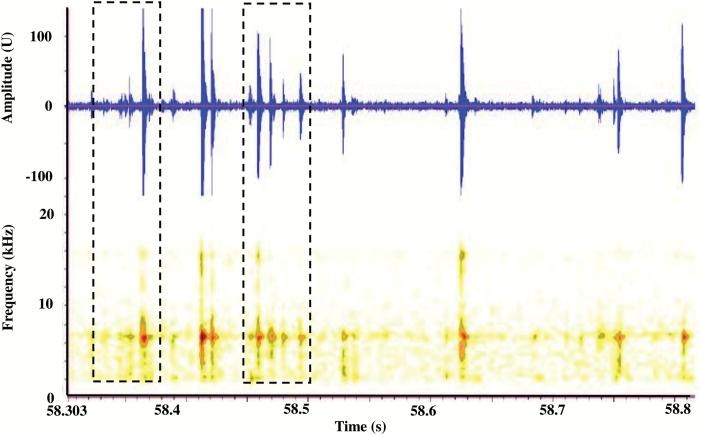
Oscillogram and spectrogram, of a 0.5-s period of impulse patterns recorded from wheat infested with 100 adults of S. oryzae contained in a 1000-ml Pyrex glass jar immediately after sealing with a rubber stopper. Activity of higher energy is denoted by darker shading on the spectrogram (256 points per spectrum, 50% overlap).